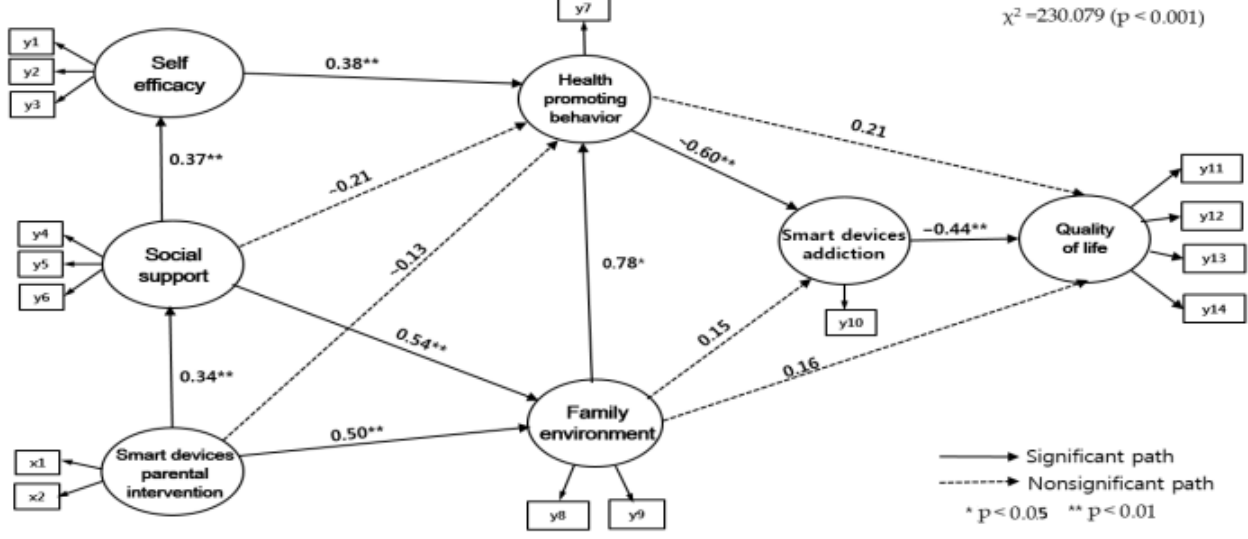
Figure 2. Path diagram of the hypothetical